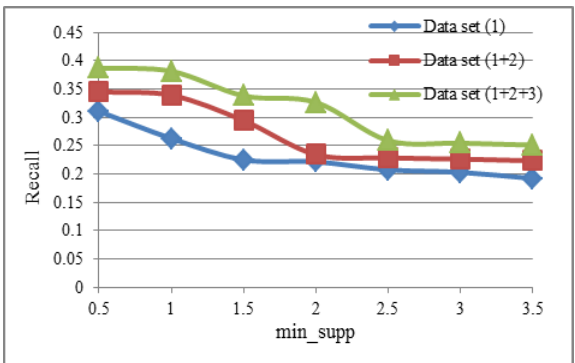
Figure 6 . Changes of recall according to min_supp of three data sets